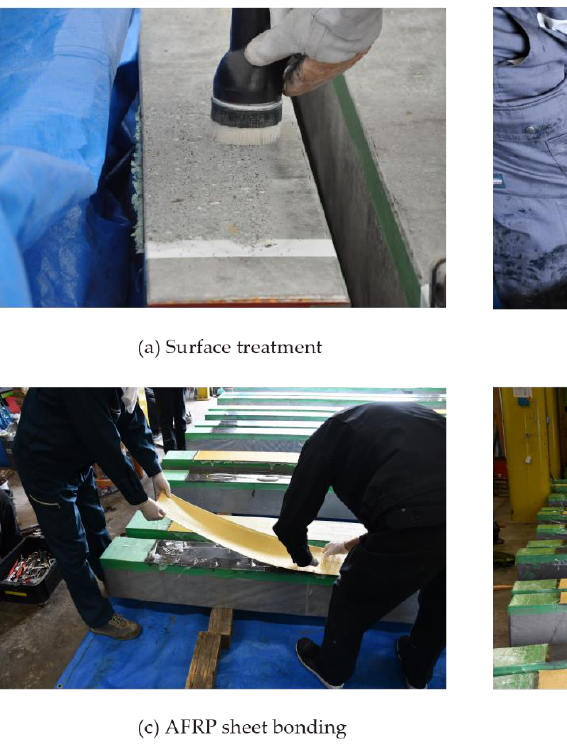
Figure 2. RC beam casting procedure.